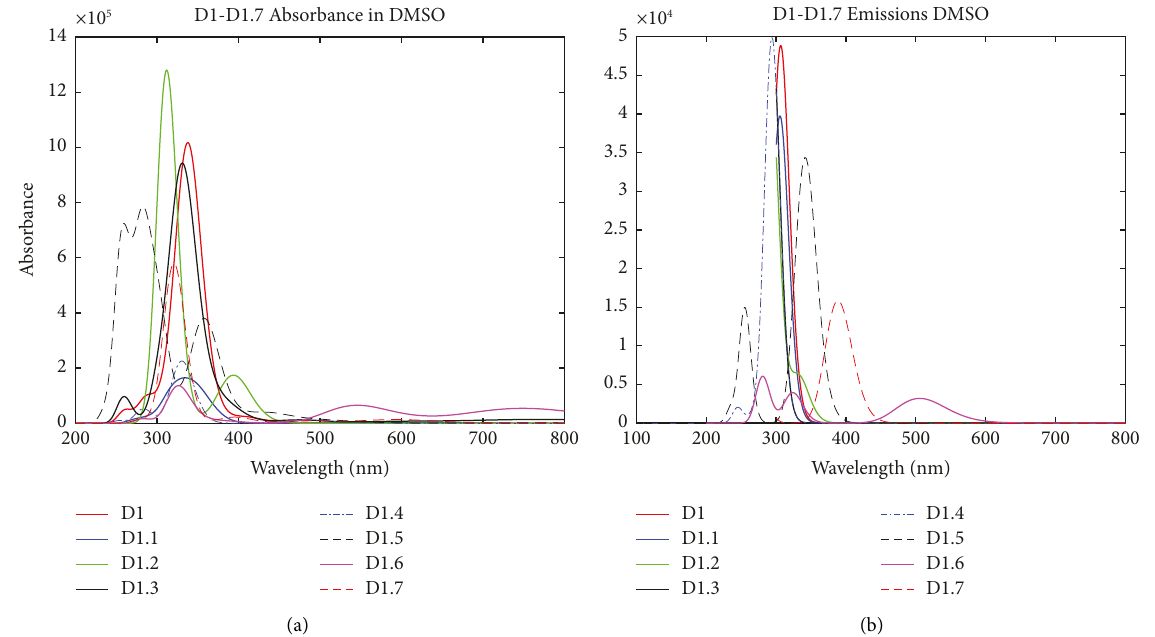
Figure 4: (a) Absorption and (b) emission spectra of the DMSO-solvated dyes (D1-D1.7) were simulated at the TD-B3LYP/6-311++G ∗∗ level of theory.